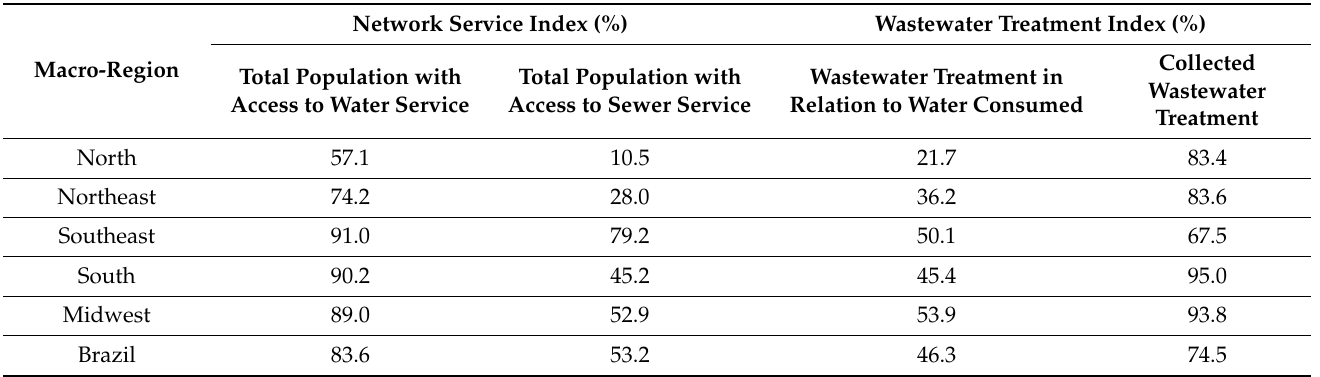
Table 1. Levels of water and sewage services presented by SNIS service providers in